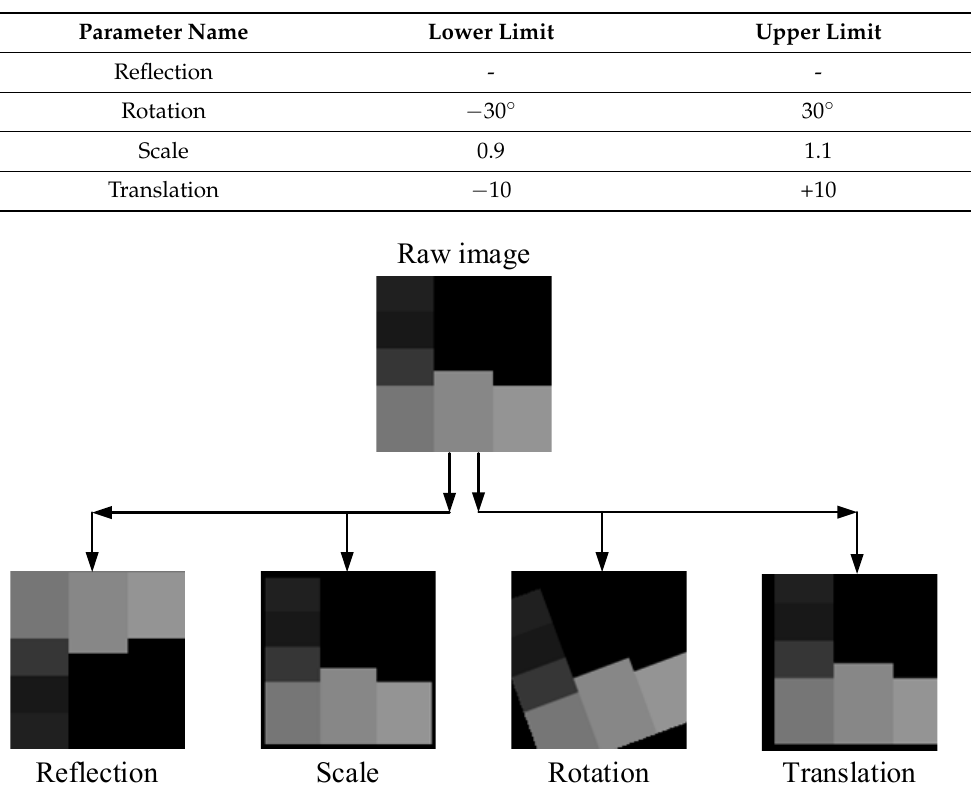
Table 3. Examination of all data before and following data